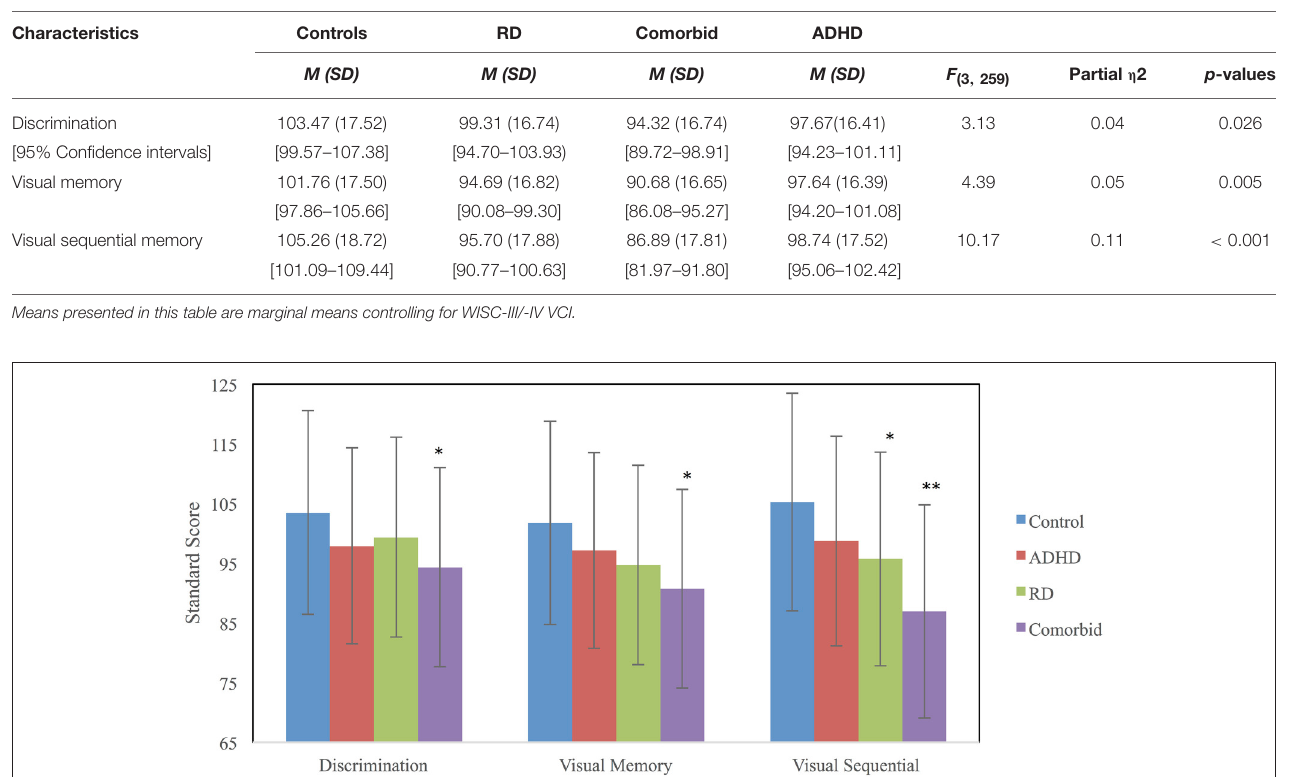
reading performance when controlling for VCI (step 1) and either phonological or orthographic processing (step 2). The first regression revealed that, after controlling for VCI and phonological awareness (Elision), visual processing predicted basic reading performance, adjusted R 2 = 0.55, F (5 , 256) = 64.67, p < 0.001. Visual Sequential Memory positively predicted basic reading performance, but Visual Discrimination and